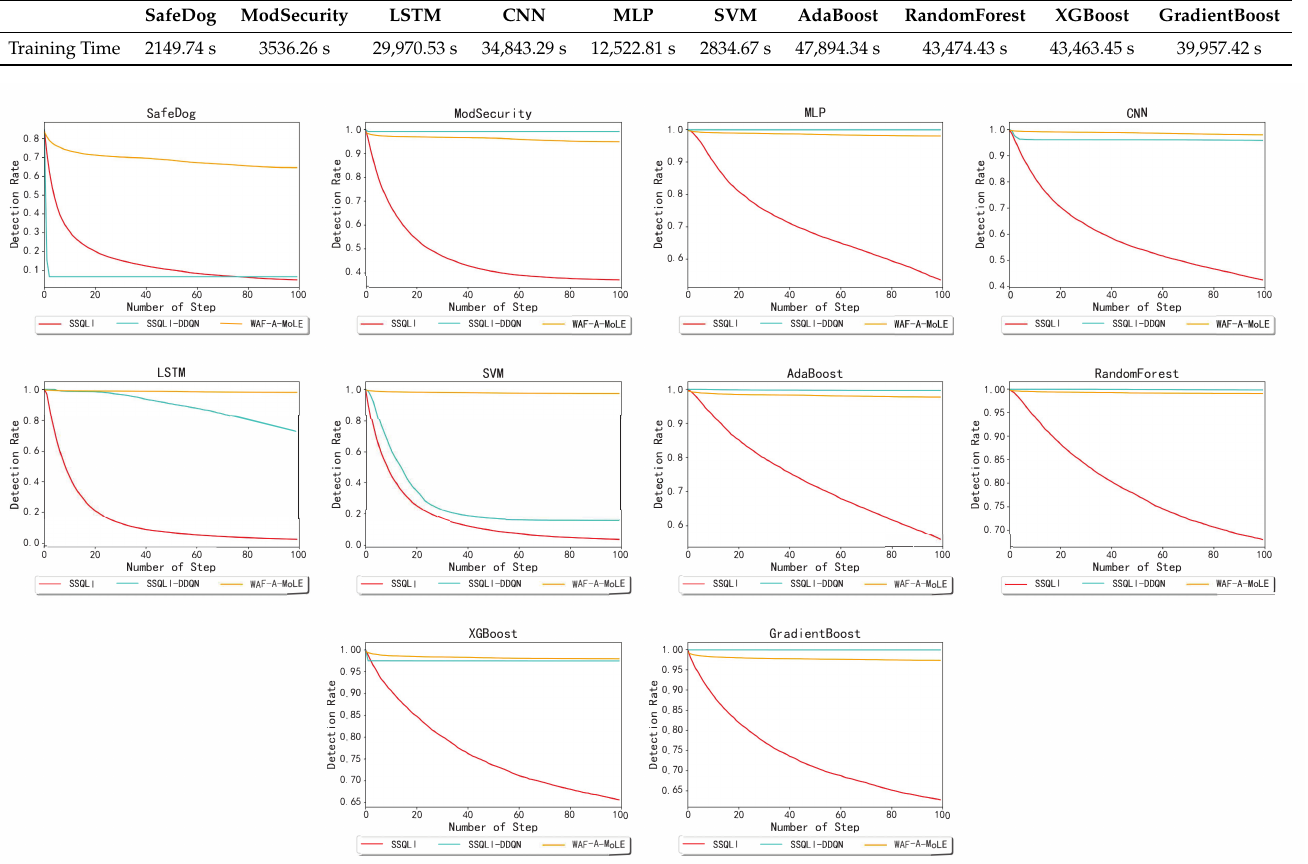
Figure 8. Mean detection rate variation curve of each detector against adversarial